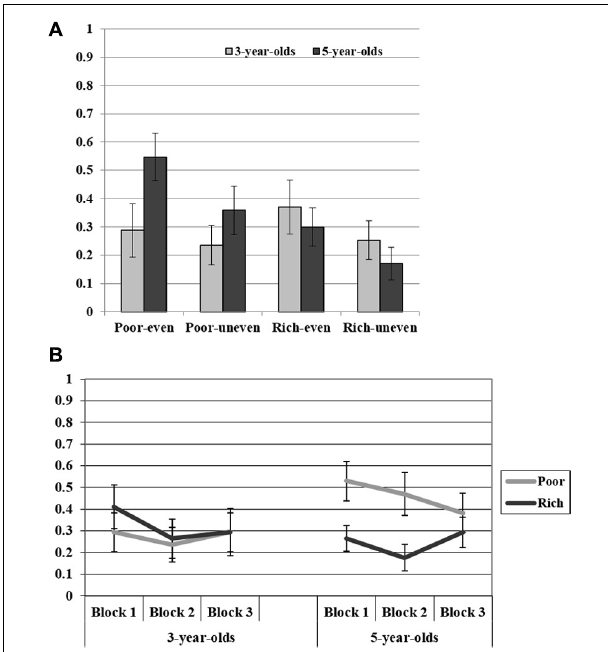
FIGURE 1 | Panel (A) shows the mean proportion of trials on which participants choose the option that afforded relatively more items to the respective recipient in Experiment 1. Panel (B) shows the mean proportion of trials (averaged across trial types) per block in Experiment 1. Error bars indicate standard errors of the